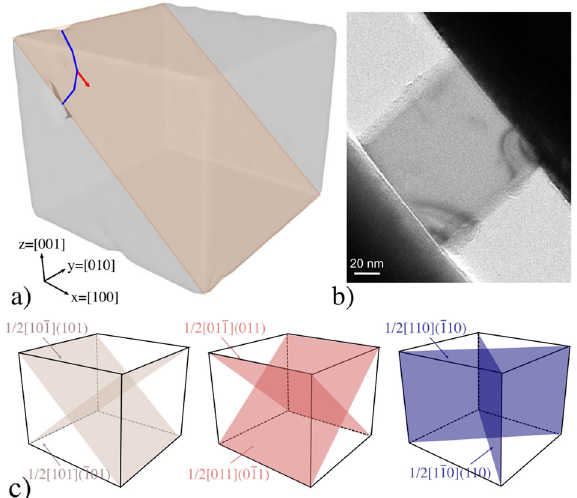
Fig. 1 Surface dislocation nucleation in MgO nanocubes and slip systems. a MgO nanocube compression modeled using MD. A h 110 i {110} dislocation nucleates from a top corner (blue perfect 1 2 line), just below the indenter. The red arrow refers to the Burgers vector direction. b Surface dislocation nucleation in a MgO nanocube observed during in situ TEM nanocompression test at room temperature (courtesy of Pr. Masenelli-Varlot). c 1 slip systems in